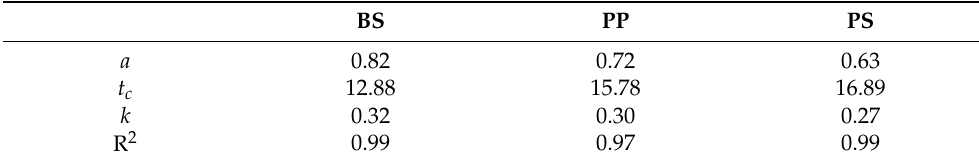
Table 2. Comparison of fitting parameters of Bacillus subtilis (BS), Pseudomonas stutzeri (PS) and Pseudomonas putida